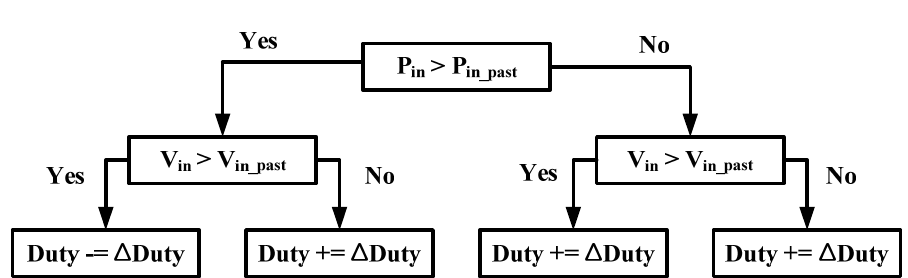
Figure 2. P&O algorithm for MPPT.